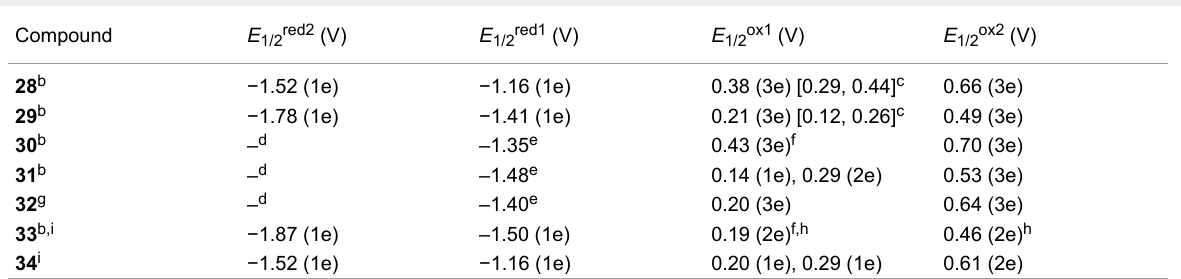
Table 4: Redox potentials of 28 – 34 measured by CV a . Compound